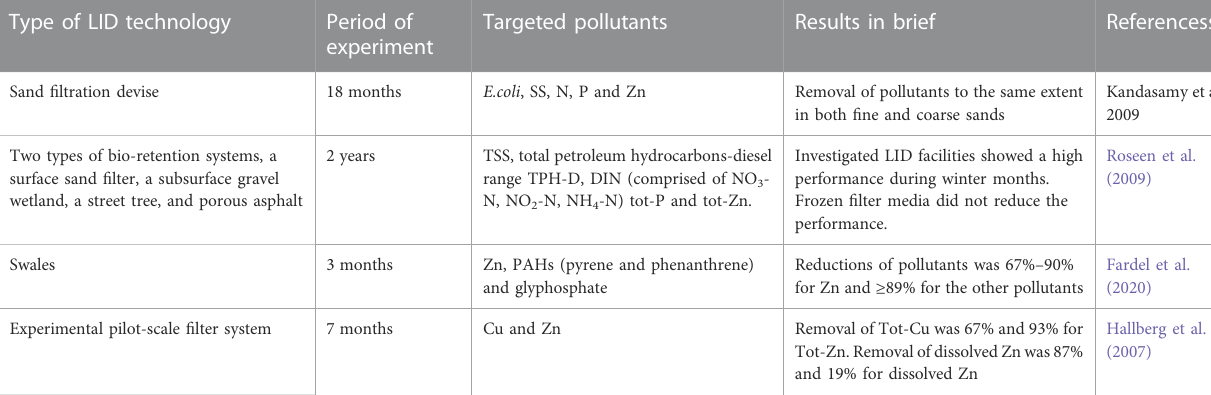
TABLE 4 Low Impact Development facilities including sand as fi lter